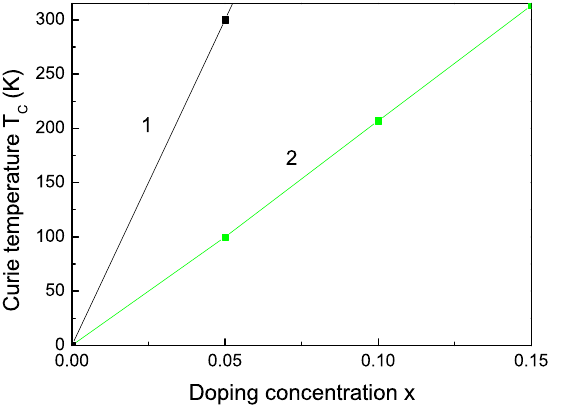
Figure 3. Co (1) and Fe (2) doping concentration dependence of the Curie temperature T C of bulk ZnS.